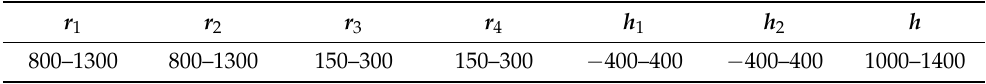
Table 1. Dimension parameter range.